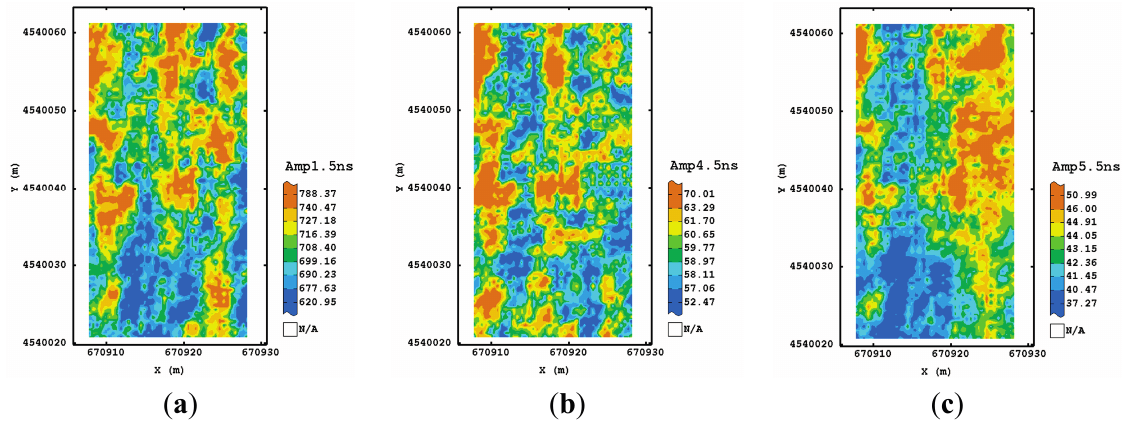
Figure 8. Maps of estimated amplitude for 600 MHz antenna frequency using the third processing procedure corresponding to 4 ns ( a ); 6 ns ( b ) and 10 ns ( c ) as an example. (Colour scale uses iso-frequency classses).